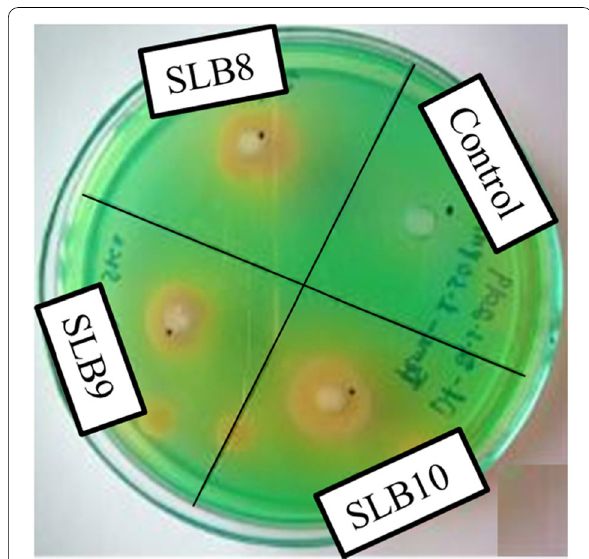
Fig. 2 Screening of ligninolytic bacterial isolates on LB agar medium containing methylene blue dye showing zone of decolourization for the bacterial isolates SLB8, SLB9, and